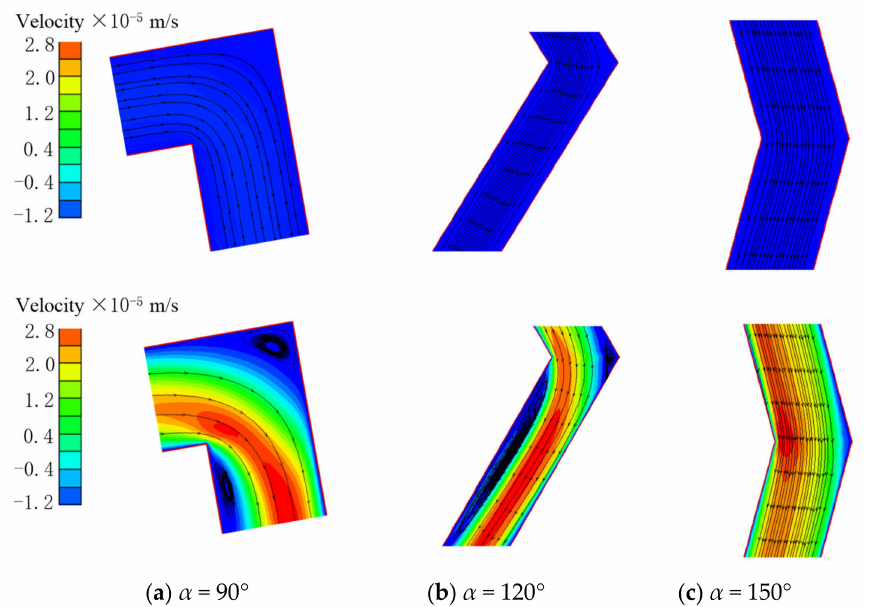
Figure 9. Flow velocity profiles for BFI at hydraulic gradient J = 0.001 (top row) and J = 0.3 (bottom row) [5].